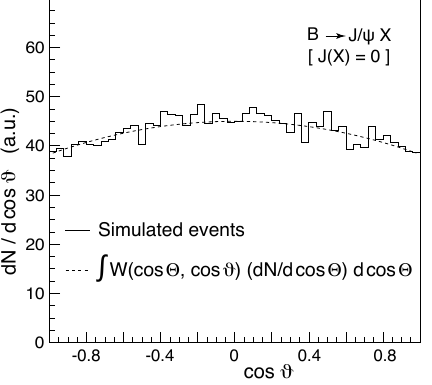
Figure 8 . Distribution of cos ϑ , in the J /ψ HX frame, corresponding to the one of cos Θ shown in figure 7. The curve is obtained by integrating the full angular distribution W (eq. (2.7)) over cos Θ , taking into account the modulation in the latter